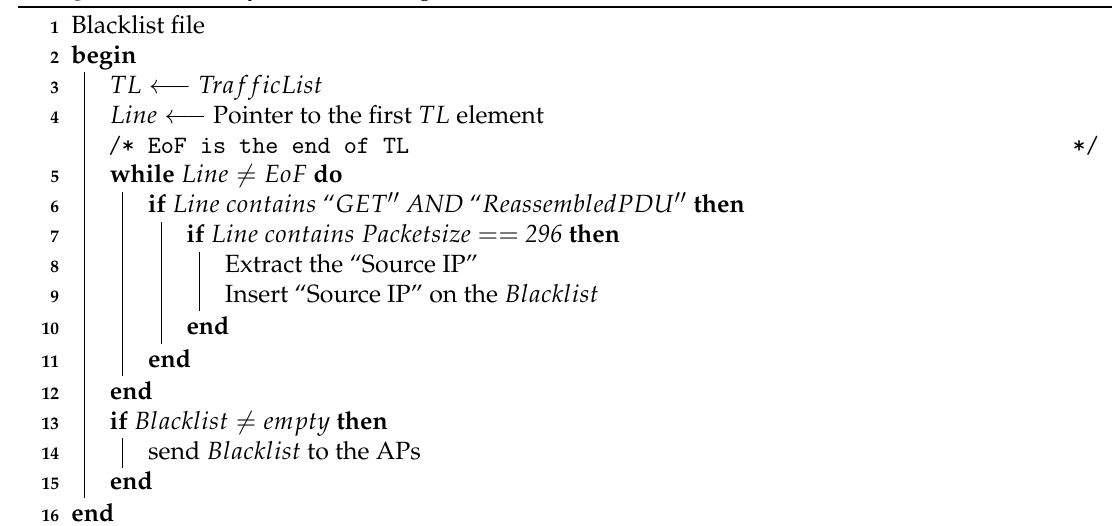
Algorithm 1: Analysis and filtering module